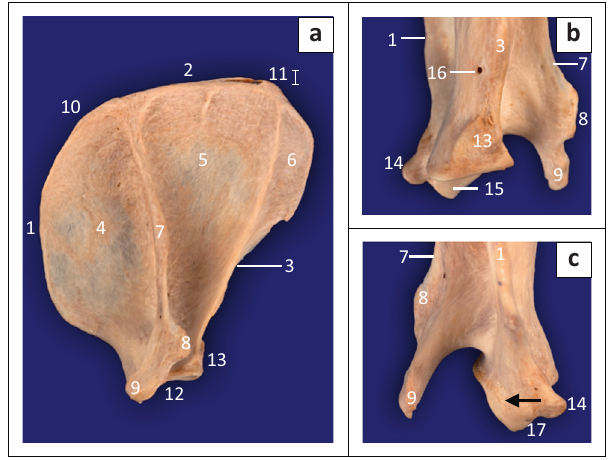
FIGURE 2: (a) Lateral, (b) caudal and (c) cranial views of a specimen of the right scapula of an adult red panda. Black arrow shows the proximal extension of the articular surface of the glenoid cavity.